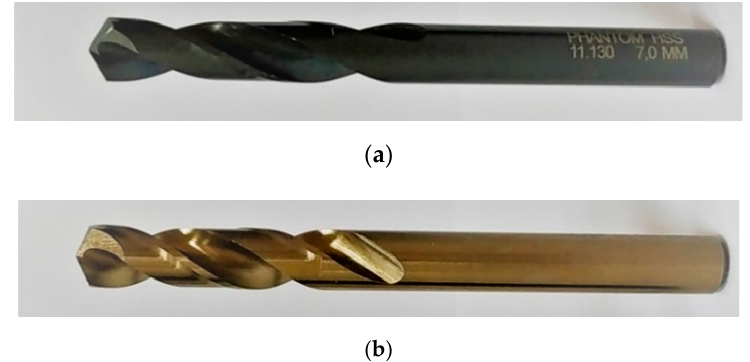
Figure 1. Twist drills for the tests; ( a ) Tool type A; ( b ) Tool type B.